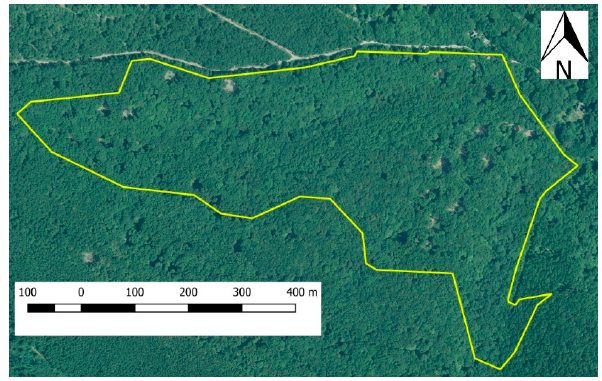
Figure 2. OS1 with an orthophoto from 2015. The spatial resolution of the orthophoto is 0.2 m.